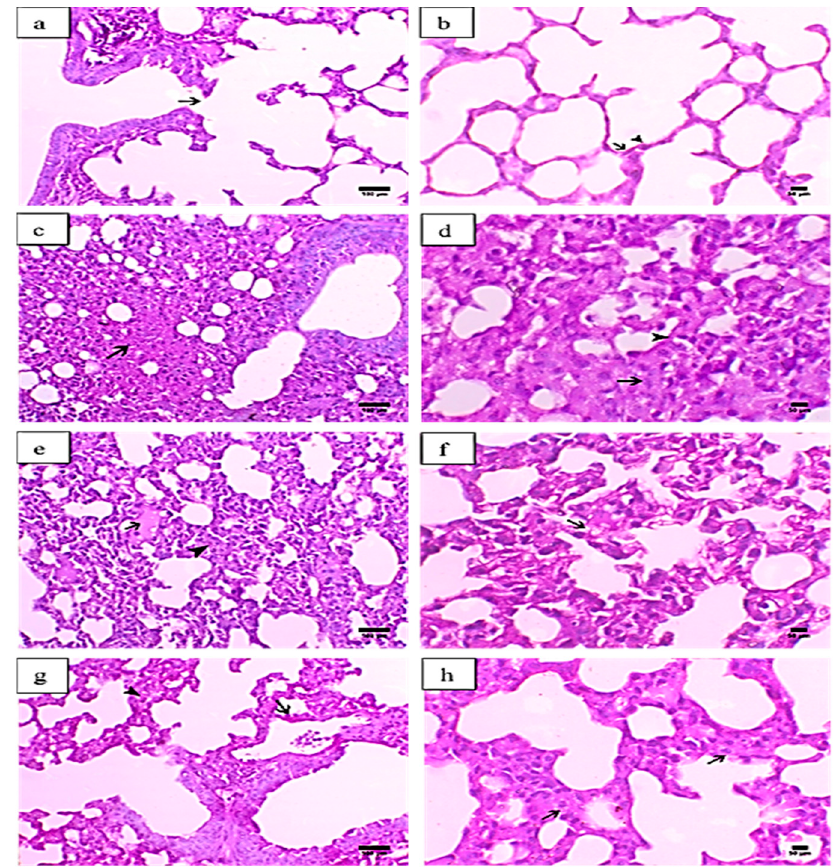
Figure 1. Histopathological graphs of lung sections from all groups. The lung sections were analyzed by hematoxylin and eosin (H&E) staining. Control group (a,b): ( a ) indicated normal terminal bronchiole ended with respiratory portion (arrow) (X200, scale bar = 100 µm), ( b ) showed alveoli lined with alveolar epithelial cells pnemocyte type I (arrow) and type II (arrowhead) (X400, scale bar = 50 µm). Paraquat (PQ) group (c,d): ( c ) presented necrosis in the alveolar tissue (arrow) (X200, scale bar = 100 µm), ( d ) showed excessive interstitial tissue thickening associated with septal cell proliferation (arrow) and alveolar hyaline membrane formation (arrowhead) (X400, scale bar = 50 µm). PQ + MEL (melittin) (0.1 mg/kg) group (e,f): ( e ) illustrated mild focal serous exudate within the alveoli (arrow) accompanied with a moderate degree of inter-alveolar interstitial tissue thickening (arrowhead) (X200, scale bar = 100 µm) ( f ) presented a moderate degree of thickening in the inter-alveolar septa and marked hyperplasia of pneumocyte type II in the lining epithelium (arrow) (X400, scale bar = 50 µm). PQ + MEL (0.5 mg/kg) group (g,h): ( g ) displayed decrease in the inter-alveolar thickening (arrowhead) with marked hyperplasia of pneumocyte type II (arrow) (X200, scale bar = 100 µm) ( h ) presented a decrease in the inter-alveolar septa (arrowhead) with an increase in the alveolar spaces associated with hyperplasia of pneumocyte type II (arrow) (X400, scale bar = 50 µm).